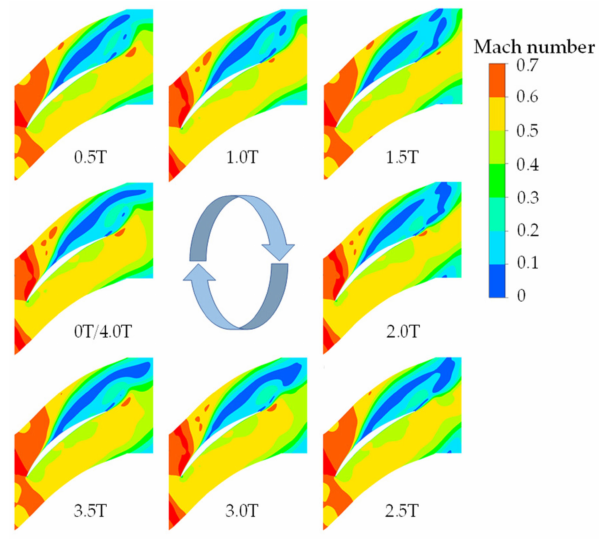
Figure 23. Mach number at the 0.95 span of